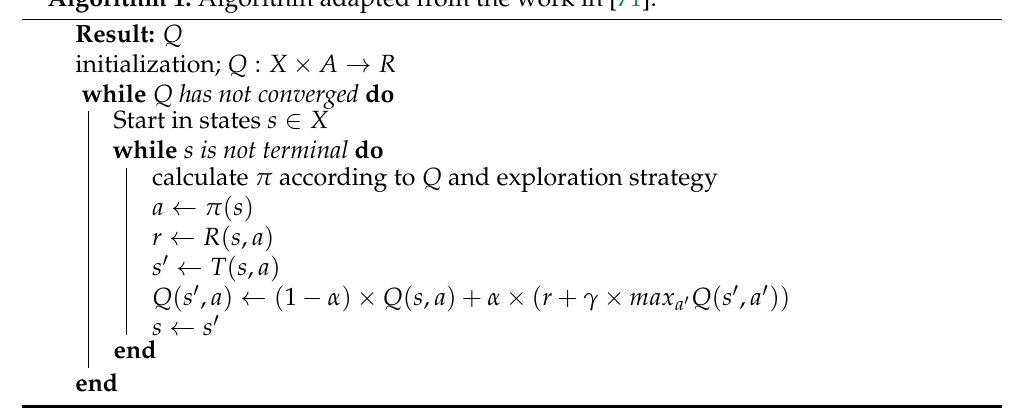
Algorithm 1: Algorithm adapted from the work in [71]. Result: